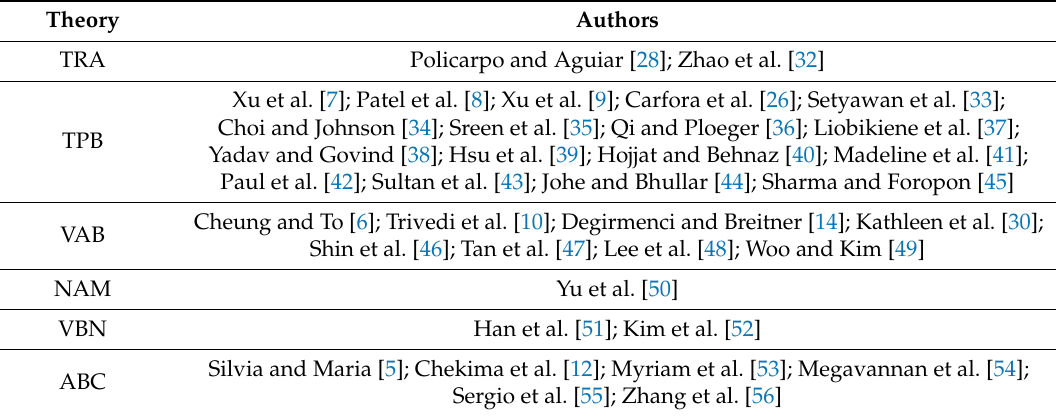
Table 2. Consumer theory with high application